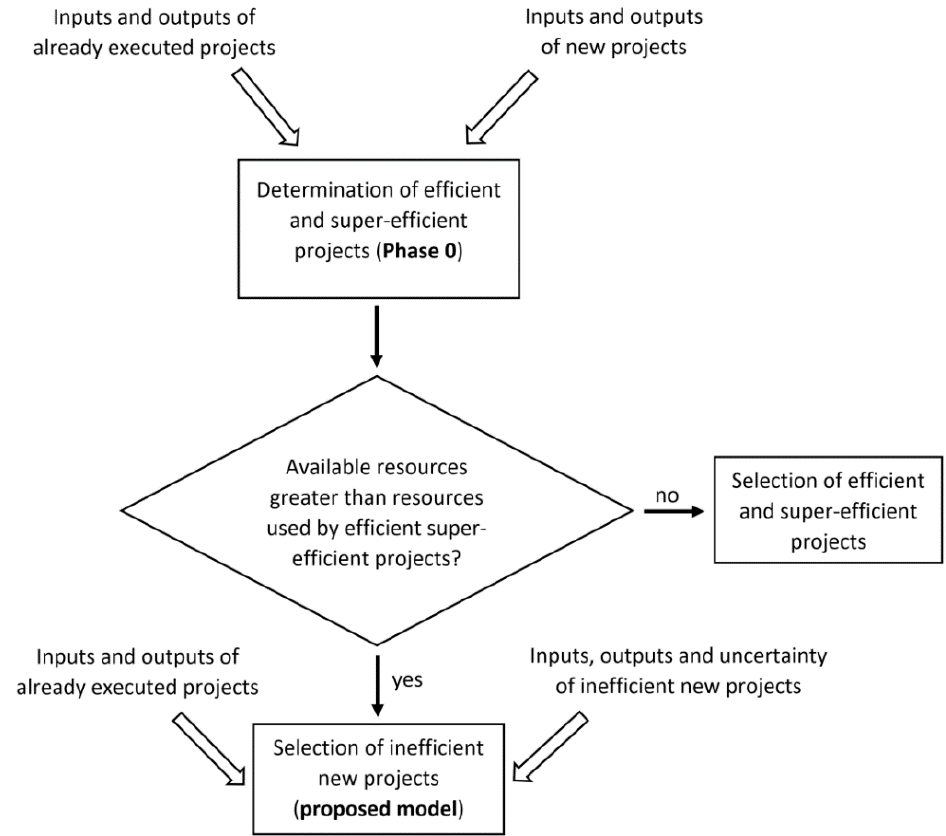
Figure 1. Representation of the proposed approach.